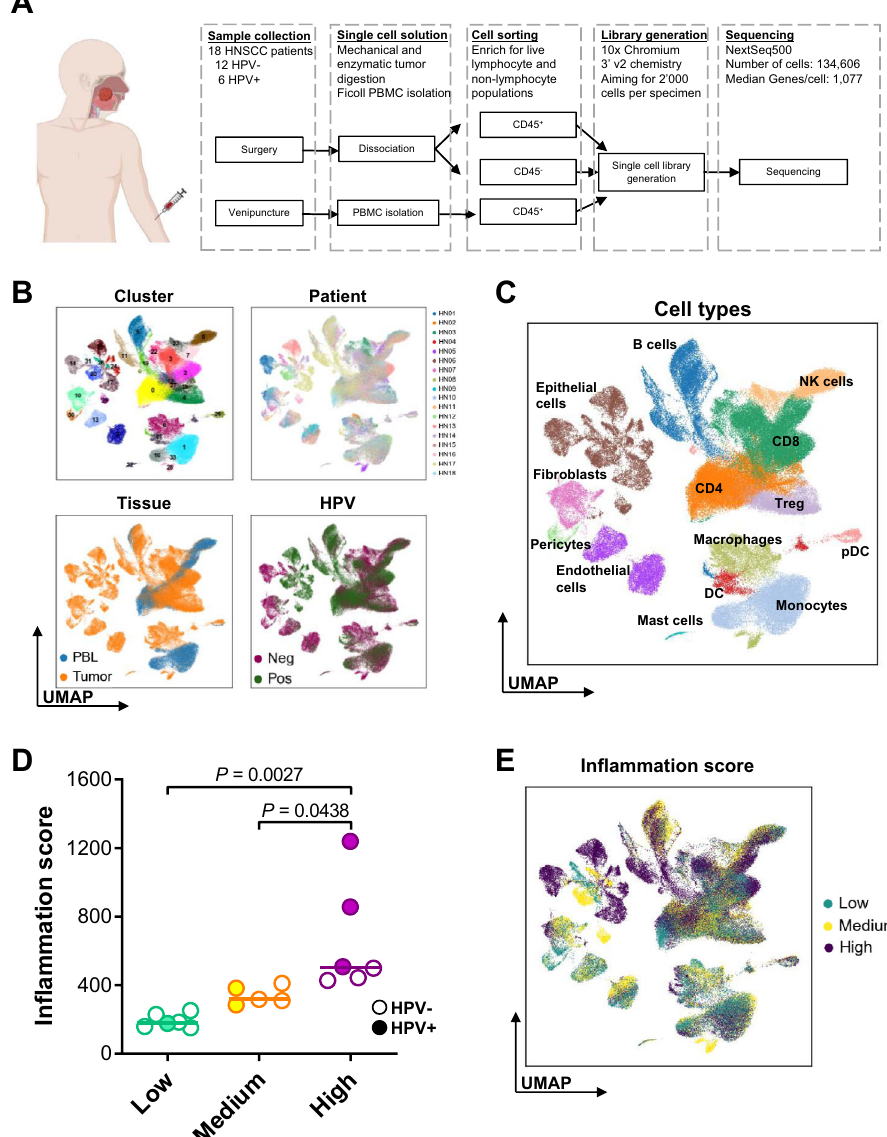
Fig. 1 Work fl ow and cohort overview with cell-type identi fi cation, naming, and in fl ammation scoring. A Fresh tumor and blood samples from HNSCC patients ( n = 18 patients) were collected, dissociated, sorted, processed using a 10× Chromium controller, and then sequenced. Patient image was created using BioRender.com B UMAP dimensionality reduction of the total cohort of 134,606 cells was performed, based on visualization of relevant characteristics: patient contribution (HN01 – HN18), cell clusters (0 – 33), tissue of origin (PBL vs. tumor), and viral-status (HPV + vs. HPV – ). C UMAP plot showing identi fi ed cell types [B cells, CD4 + T cells, CD8 + T cells, dendritic cells (DC), plasmacytoid DC, endothelial cells, epithelial cells, fi broblasts, pericytes, macrophages, monocytes, natural killer (NK) cells, T regulatory (Treg) cells, mast cells]. D In fl ammation scores were determined by quantifying the total leukocyte in fi ltrate in each tumor based on H&E staining ( n = 17 patients). Tertiles were used to segregate patients into three groups based on their in fl ammation score: low ( n = 6 patients), medium ( n = 5 patients), and high ( n = 6 patients). Patients with HPV + and HPV – etiologies are indicated. Center lines represent median values for each cohort. In fl ammation scores were evaluated using a one-way ANOVA test. E UMAP plot showing cell contributions based on in fl ammation Identi fi cation and characterization of HPV + and HPV – cancer DNA-damage-inducible, beta), BTG2 (encodes BTG anti- cells . Unlike previous scRNAseq analyses of HNSCC 9,10 , this proliferation factor 2), JUN (encodes Jun proto-oncogene), and FOS (encodes Fos proto-oncogene). These genes were also study extensively compares the immune as well as cancer/stromal enriched in the TNF-signaling pathway. This suggests a cell landscapes of two contrasting, HPV – and HPV + tumor etiologies, the latter of which have better clinical outcomes 23 . We qualitative difference of CD8 + T cells depending on the in fl ammation status of the TME, with cells from tumors with identi fi ed and subclustered 14,920 cells of epithelial origin high in fl ammation scores being more activated and effector-like, (Fig. 3A). The cancer cell phenotype was determined by copy while cells from tumors with low in fl ammation score are stressed number variation (CNV, Supplementary Fig. 4A) analysis and by the surrounding TME and may become (pre)-apoptotic. keratin expression (Supplementary Fig. 4B), as utilized